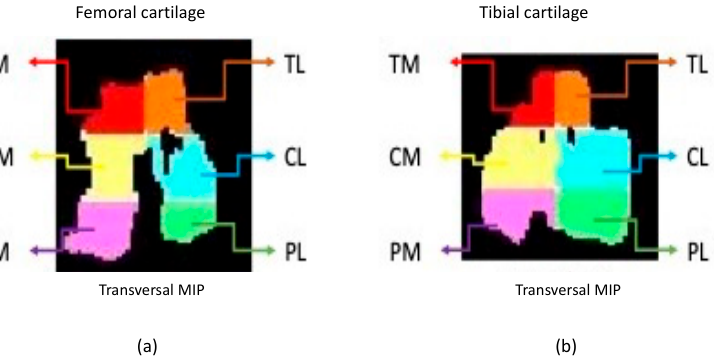
Figure 1. Transversal femoral ( a ) and tibial ( b ) cartilage parcellation over maximum intensity projection (MIP).